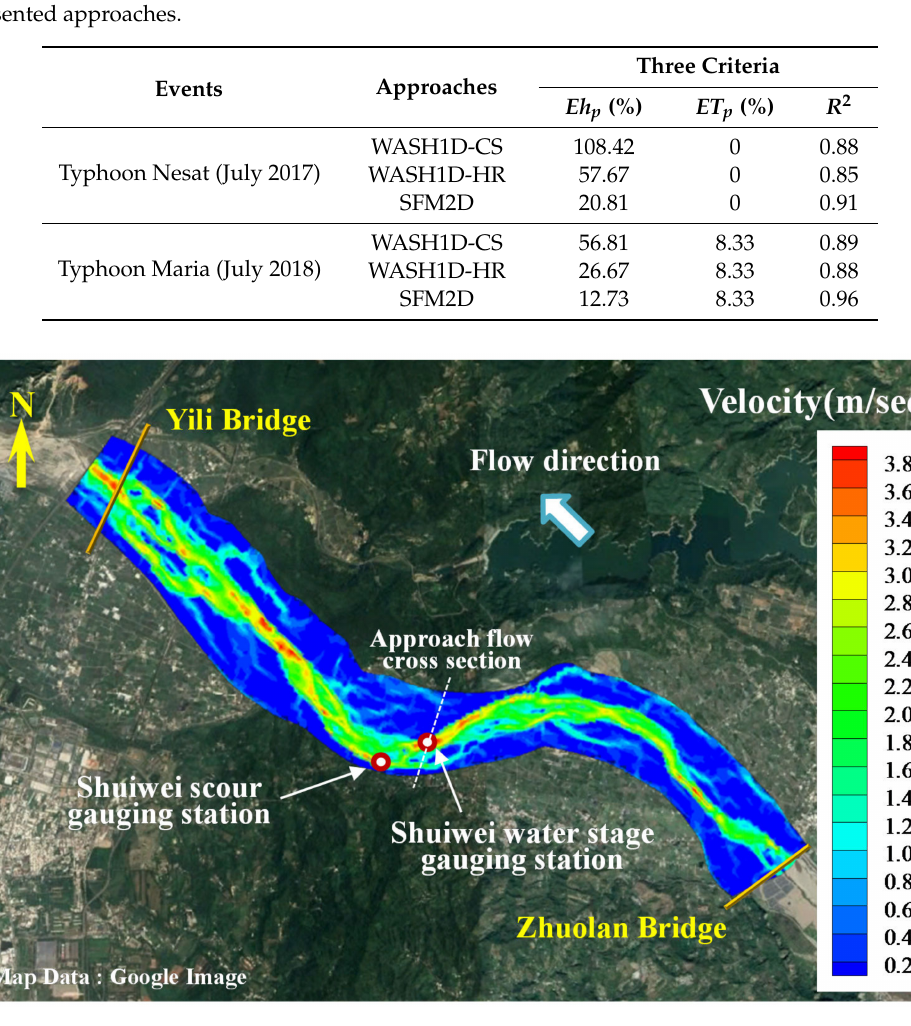
Figure 12. Contour plot illustrating the flow velocity under peak-flood condition for Typhoon